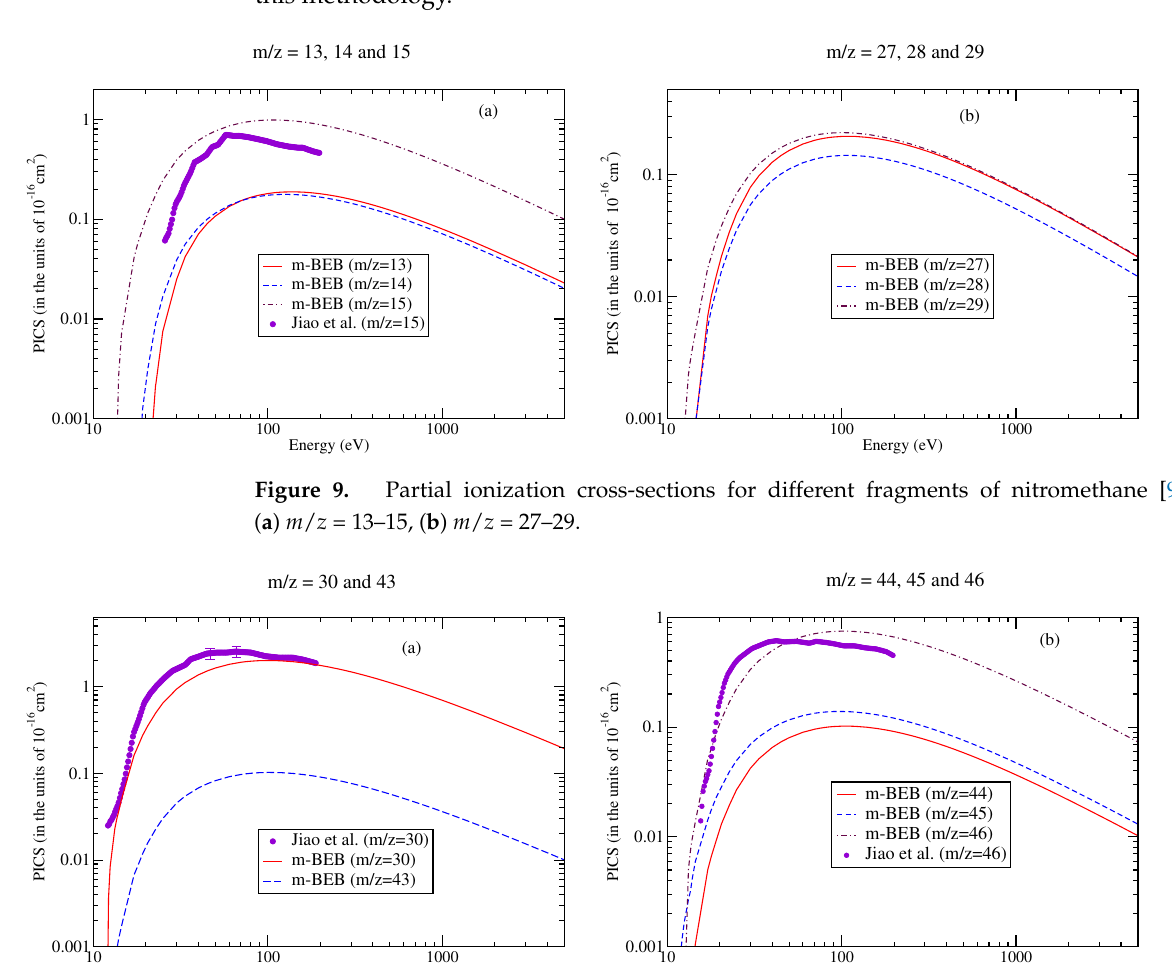
0.001 1000 Energy (eV) Figure 10. Caption same as Figure 9 for ( a ) m / z = 30, 43, ( b ) m / z =